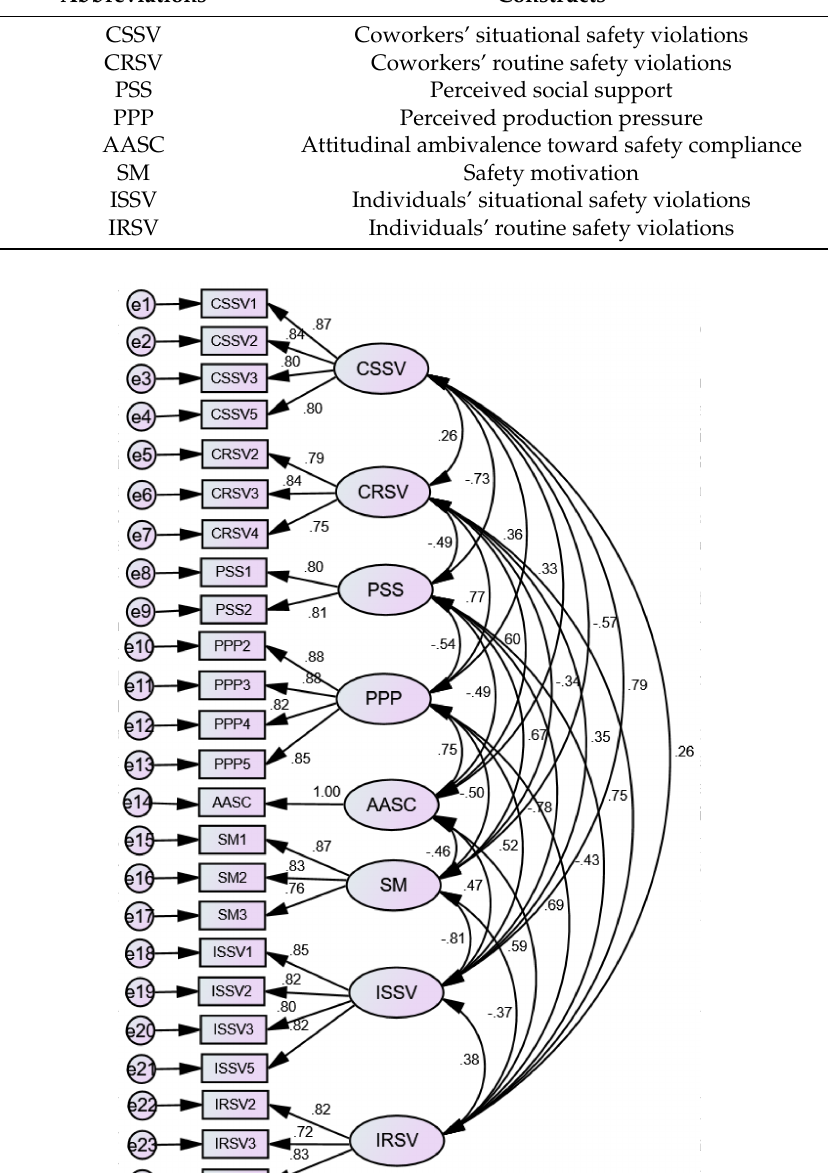
= 1.752; CFI = 0.971; TLI = 0.964; df